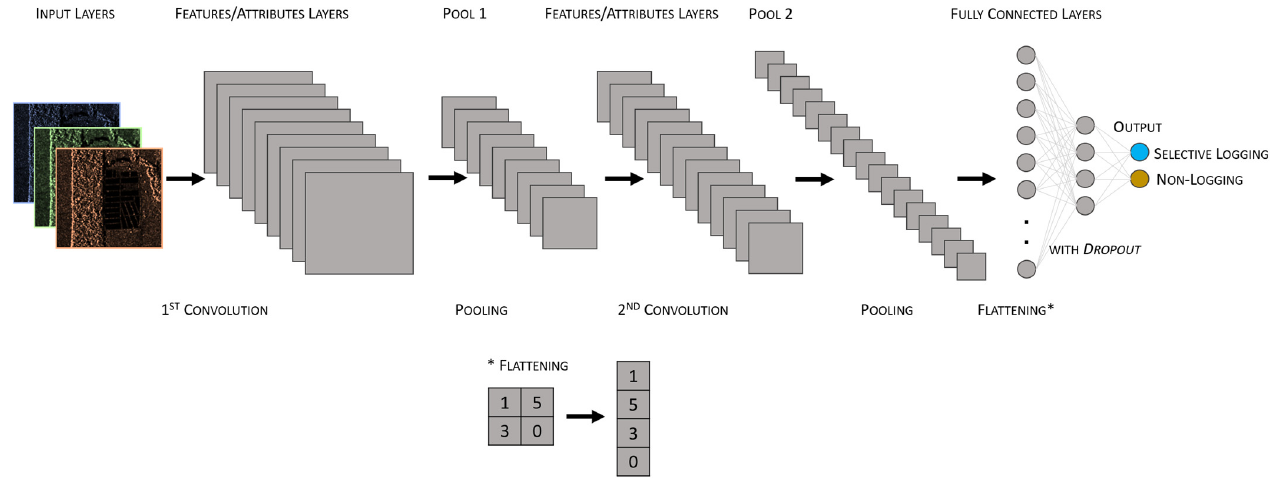
Figure 2. Schematic diagram of a generic architecture Convolutional Neural Network. The input of convolutional layers 𝑋 ∈ ℝ (cid:3041) (cid:3400)(cid:3050)(cid:3400)(cid:3035) consists of n 2D feature/attribute maps of size 𝑤 (cid:3400) ℎ . The output 𝐻 ∈ ℝ (cid:3040) (cid:3400)(cid:3050)(cid:4593)(cid:3400)(cid:3035)(cid:4593) of the convolutional layers are m 2D fea- ture/attribute maps of size 𝑤′ (cid:3400) ℎ′ via convolution matrix W . 𝑊 ∈ ℝ (cid:3040) (cid:3400)(cid:3039)(cid:3400)(cid:3039)(cid:3400)(cid:3041) are the m trainable filters of size 𝑙 (cid:3400) 𝑙 (cid:3400) 𝑛 (usually 𝑙 = 1, 3, or 5). The convolution process is de- scribed as 𝐻 (cid:3404) 𝑓(cid:4666)𝑊 ∗ 𝑋 (cid:3397) 𝑏(cid:4667) , where * denotes 2-D convolution operation and b the bias.